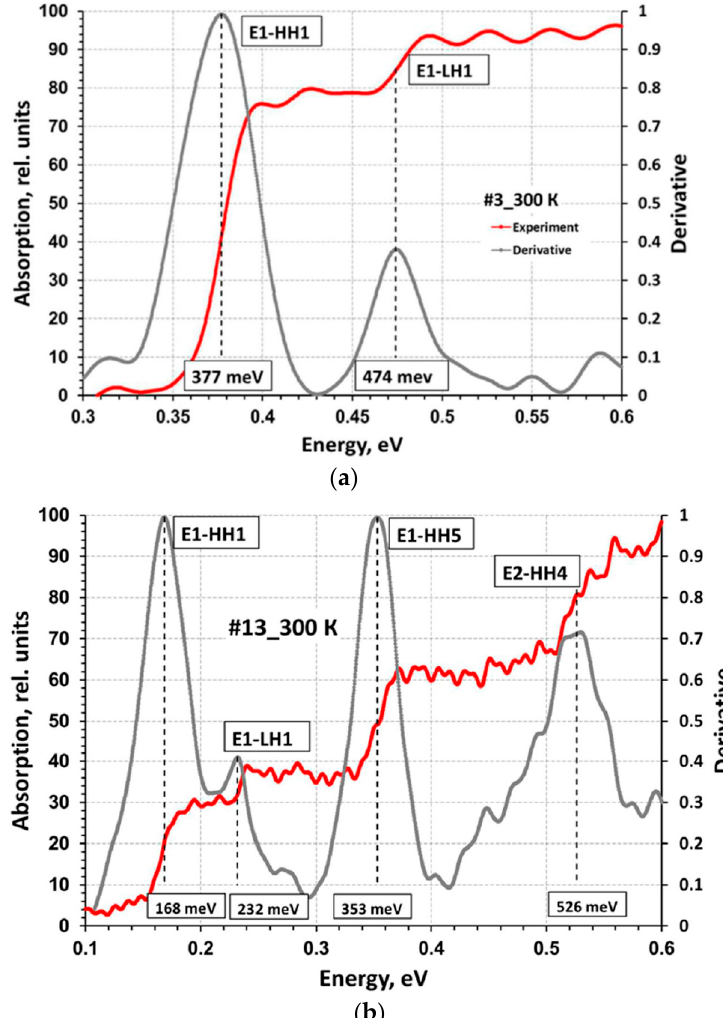
Figure 5. Experimental absorption (red lines) and their first derivatives (grey lines) for the samples #2 and #15 at room temperature. The interband electronic transition energy is indicated by vertical lines. In squares are shown E1-HH1, E1-LH1 for the sample #2 and E1-HH1, E1-LH1, E2-HH2, E2-HH4 for the sample #15 interband electronic transition and their energies.